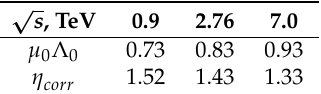
Figure 3. The strongly intensive observable, Σ ( n pseudorapidity windows (of the width δη = 0.2 and 0.4) as a function of the distance between window centers, ∆ η at three initial energies: 0.9, 2.76 and 7 TeV.